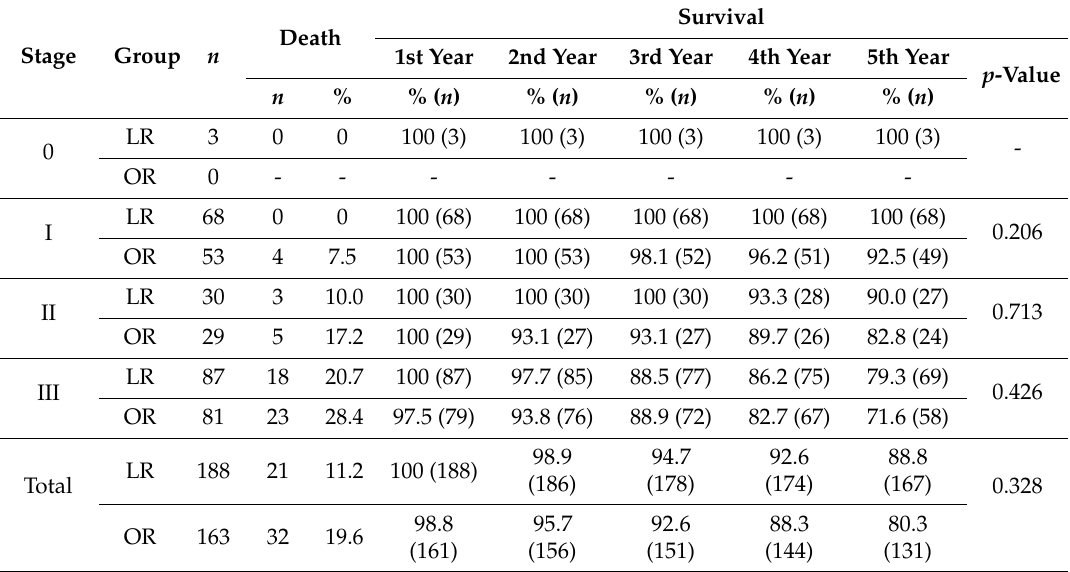
Table 3. Cancer-free survival rates between laparoscopic resection (LR) versus open resection (OR).